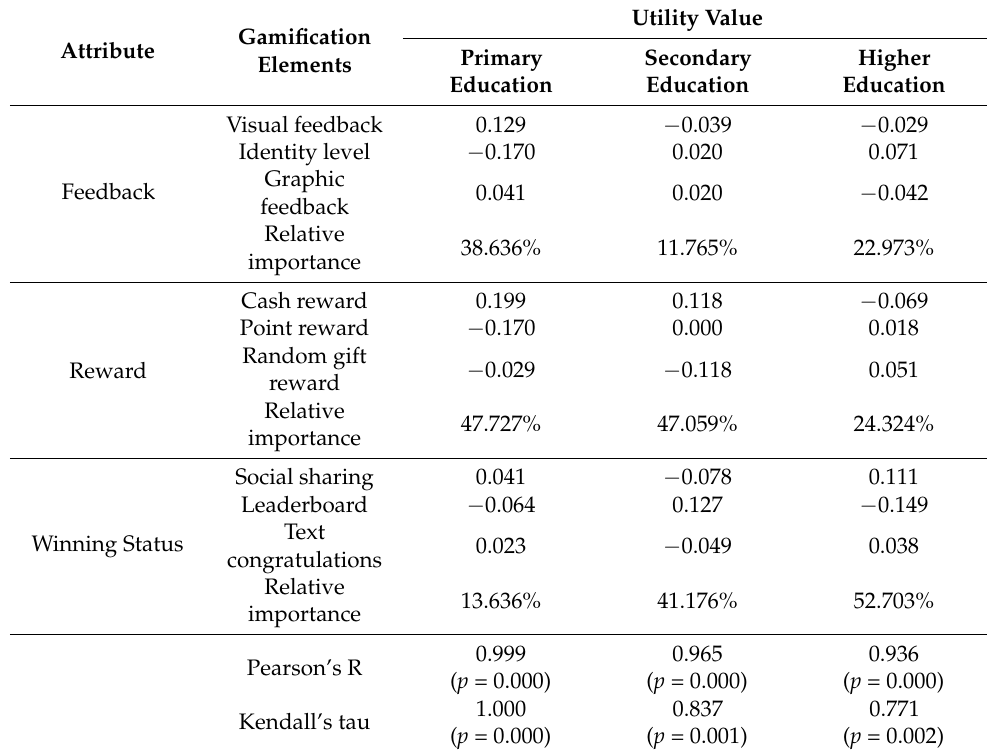
Table 9. Utility value of attribute levels classified by educational